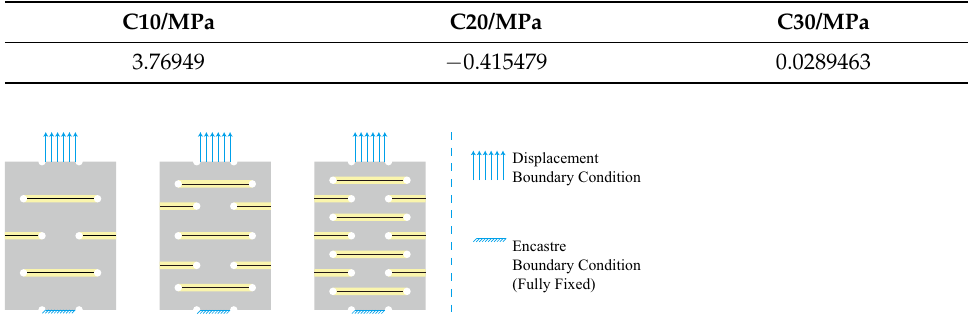
Figure 7. Schematic diagram of the boundary conditions setup in finite element analysis